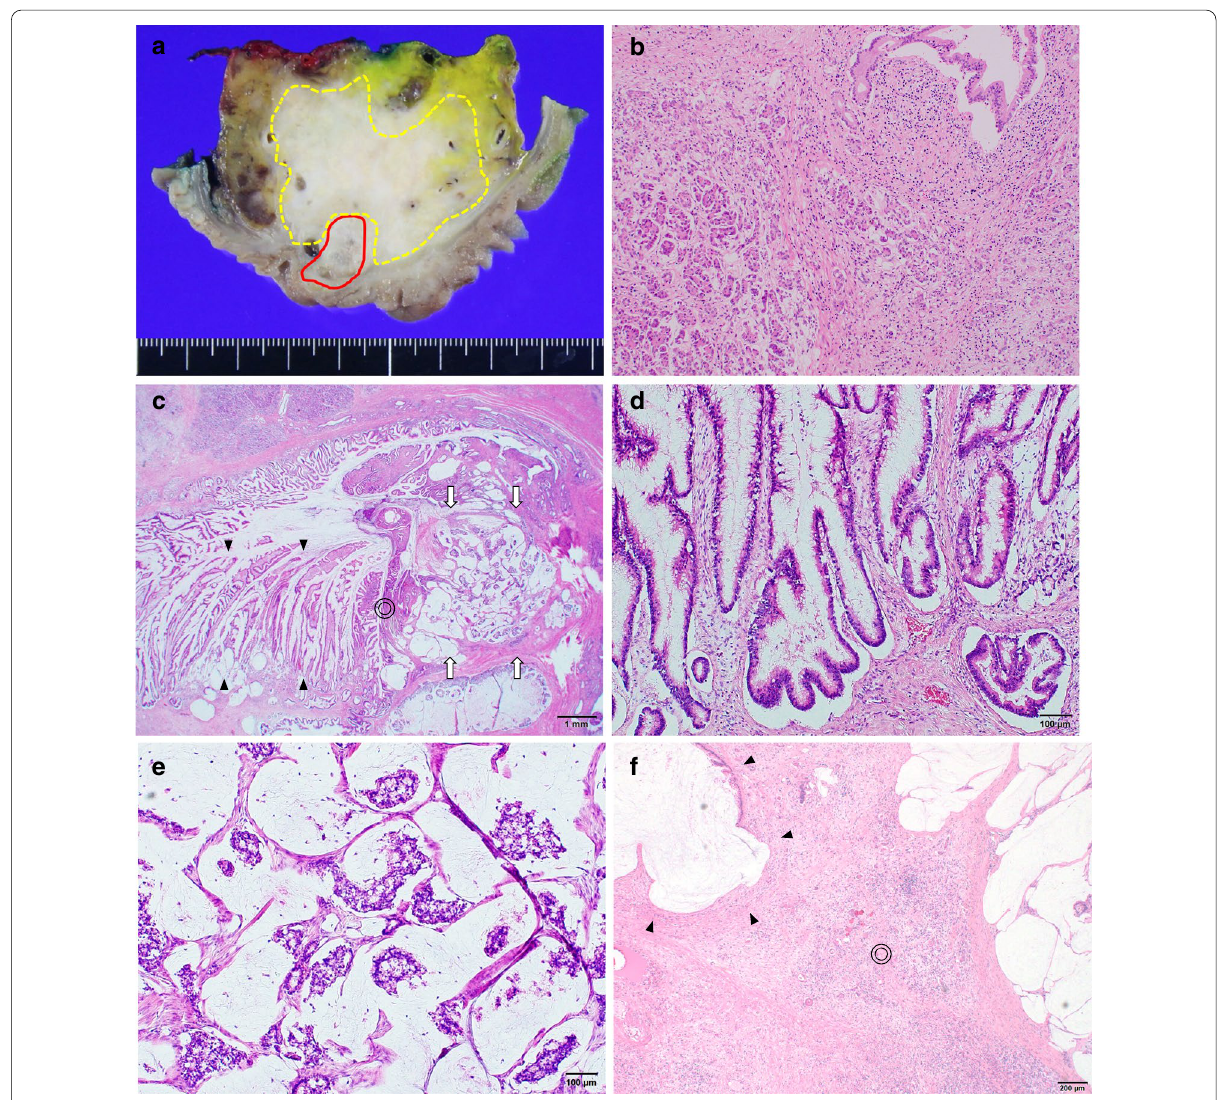
Fig. 4 Pathology specimen. a Gross cross-section of the pancreatic head, showing a tumor lesion (solid line) pervading a white lesion with obscure margins (dotted line) and the lumen of the duodenal papillary common channel. b Mid-magnification image (HE staining 40) of the white × lesion (dots in a ). Atrophic pancreatic tissues with fibrogenesis and inflammatory cell infiltration. c Low-magnification image (HE staining 12.5) × of the duodenal papillary common channel (solid line in a ). In the sphincter of Oddi, a papillotubular tumor pervading the lumen was observed (arrowhead). A mucinous nodular lesion (arrow) was found in the stroma, with transiting images of the tumor (double circle). d High-magnification image (HE staining 100) of the arrowhead in c . Hyperplasia of tumor cells with findings of papillotubular growth, IAPN, and low-to-high-grade × dysplastic adenocarcinoma. e High-magnification image (HE staining 100) of the arrow in c . The lesion formed multiple neoplastic mucinous × nodes, indicating findings of mucinous carcinoma derived from IAPN. f Mucinous adenocarcinoma infiltrating to the parenchyma of the fibrotic pancreas (HE staining 40). Mucinous adenocarcinoma (arrowhead) was infiltrating to the parenchyma of the pancreas (double circle). The × pancreatic parenchyma was excessively atrophic with the inflammatory cell